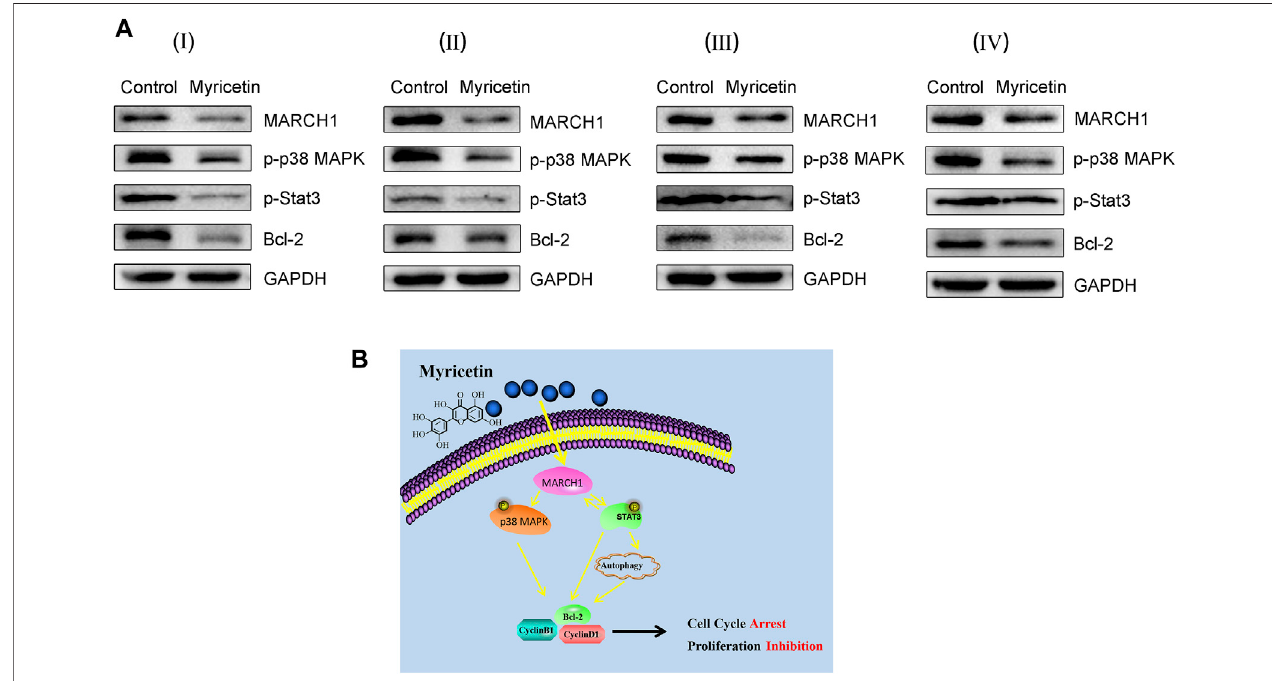
FIGURE 7 | Myricetin restricts HCC tumor growth by downregulating MARCH1-mediated of p38 MAPK/Stat3 pathway. (A) The expression of MARCH1,p-p38 MAPK,p-Stat3,andBcl-2intumortissuesdetectedbyWesternblot. (B) ThemechanismmodelofmyricetinininducingHCCautophagyandcellcycle arrest to inhibit HCC